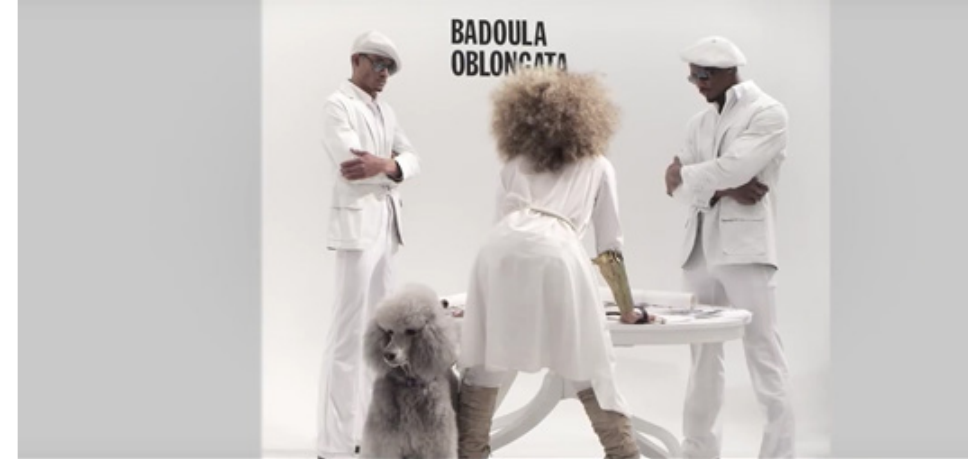
Figure 2 Still from the music video showing Erykah Badu frozen in time (“Q.U.E.E.N” 00:0:35) Eventually, when the singers and musicians start to move and perform the song, they disrupt the